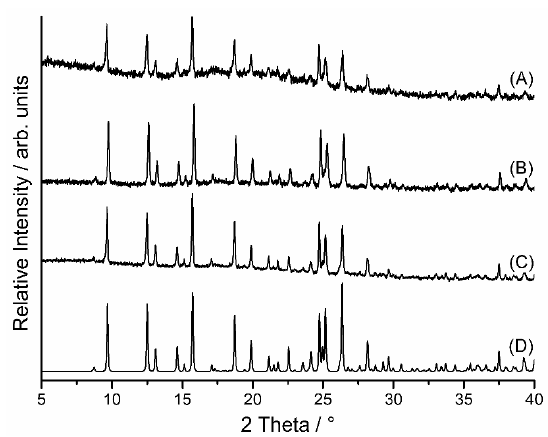
Figure 7. Experimental XRPD patterns of the residue obtained from 4 ( A ); 3 ( B ) and from 2 ( C ) and calculated XRPD pattern of compound 5 ( D ).